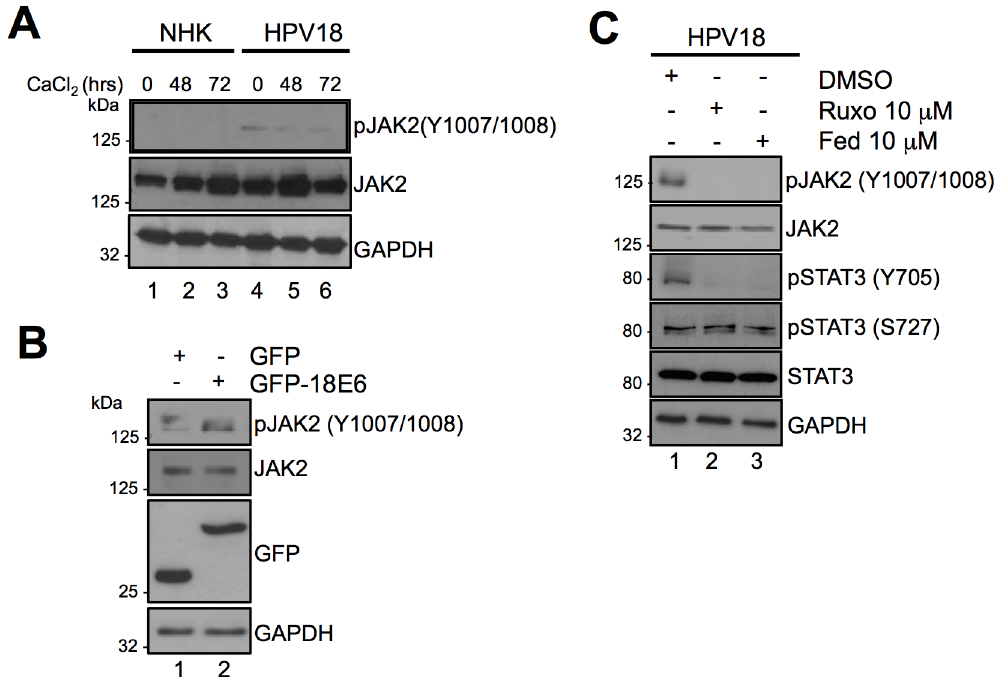
Fig 4. Janus kinases (JAK) are responsible for mediating Y705 phosphorylation in E6 and HPV18 containing keratinocytes. A) Representative western blot of keratinocytes subjected to high calcium differentiation analysed with antibodies specific for the total and phosphorylated forms of JAK2 (Y1007/1008). GAPDH served as a loading control. Data shown are representative of at least three independent biological repeats. B) Representative western blot of C33a cells transfected with GFP and GFP tagged HPV18 E6 and analysed using specific antibodies detecting phosphorylated (Y1007/ 1008) and total JAK2. Expression of E6 was confirmed using a GFP antibody. GAPDH served as a loading control. C) Representative western blots of HPV18 containing keratinocytes incubated with the JAK1/2 inhibitor Ruxolitinib or JAK2 inhibitor Fedratinib analyzed with antibodies detecting total and phosphorylated forms of JAK2 and STAT3. GAPDH served as a loading control. Data shown are representative of at least three independent biological